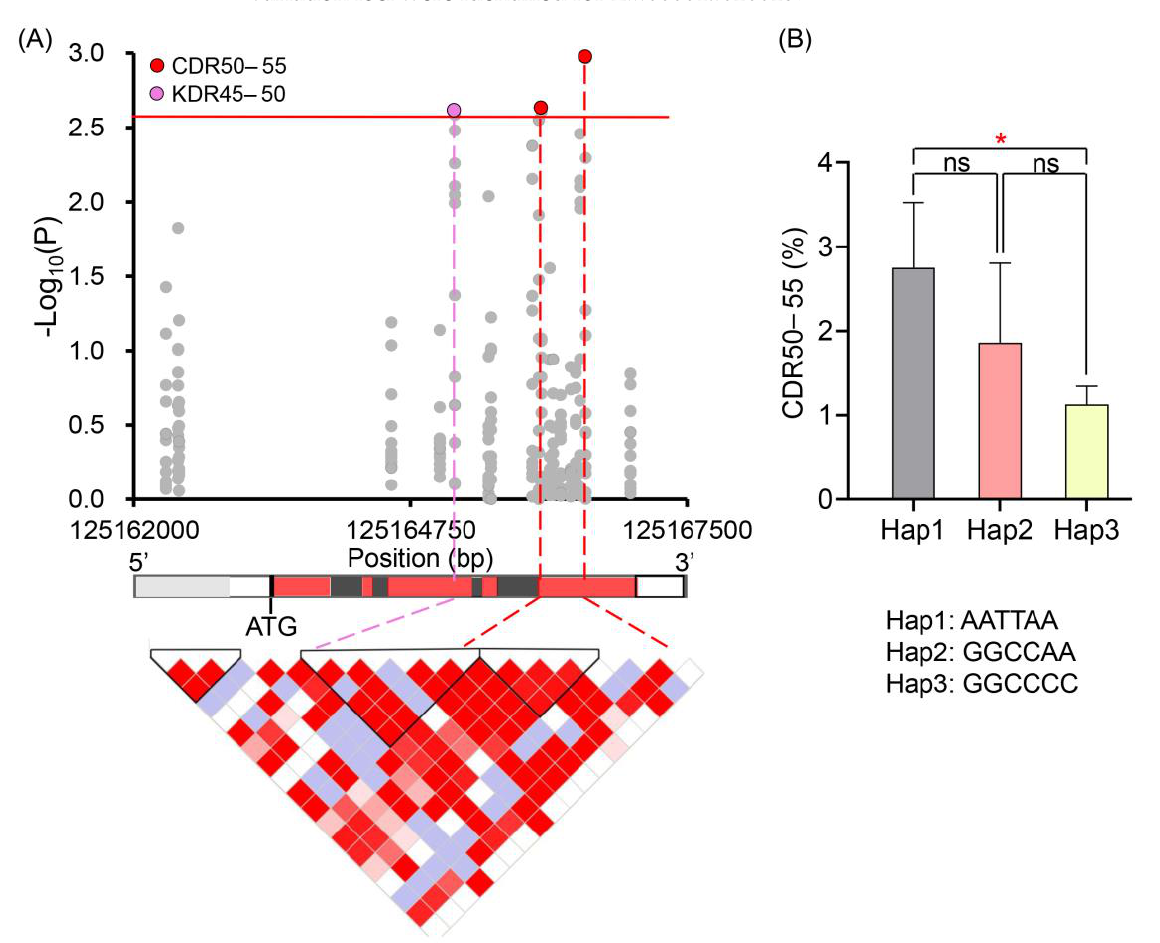
Figure 3. Association analysis of Zm00001d020615 . ( A ) Significant SNPs associated with CDR50–55 and KDR45–50. CDR50–55 represent cob dehydration rate at 50–55 days after pollination; KDR45–50 represent kernel dehydration rate at 45–50 days after pollination. Red line shows the significant threshold of markers. The boxes with gray, white, red, and black colors represent promoter (upstream 2000 bp), UTR, exons, and introns, respectively. Bottom plot shows the pairwise linkage disequilib- rium between the target SNP markers. ( B ) Comparison of three haplotypes for CDR50–55. CDR50–55 represent cob dehydration rate at 50–55 days after pollination. Hap1, haplotype1; Hap2, haplotype2; Hap3, haplotype3. * Significant at p < 0.05. ns, no significant. Table 3. Gene-based association studies detected significantly associated variants within Zm00001d020615 . Trait Marker Position p -Value Allele Variation